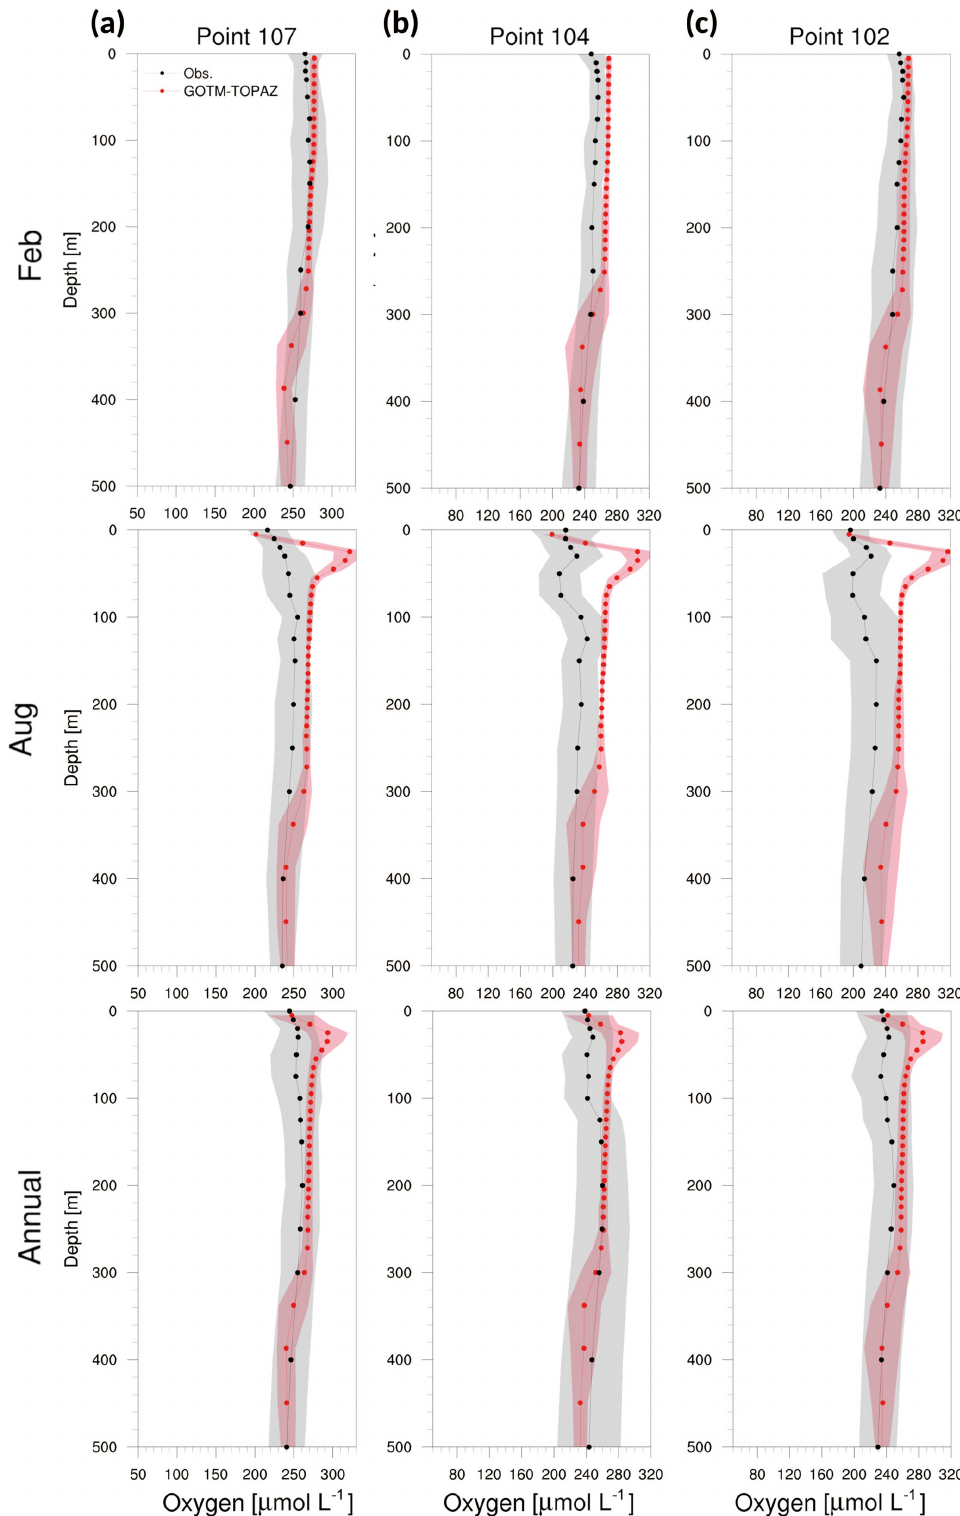
Figure 14. Vertical profiles from observations (black dots) and GOTM–TOPAZ results (red dots) for concentrations of dissolved oxygen av- eraged from 1999 to 2008, (a) for point 107, (b) for point 104, and (c) for point 102. GOTM–TOPAZ is simulated by prescribing observations for the initial data. The shaded areas represent 1 σ